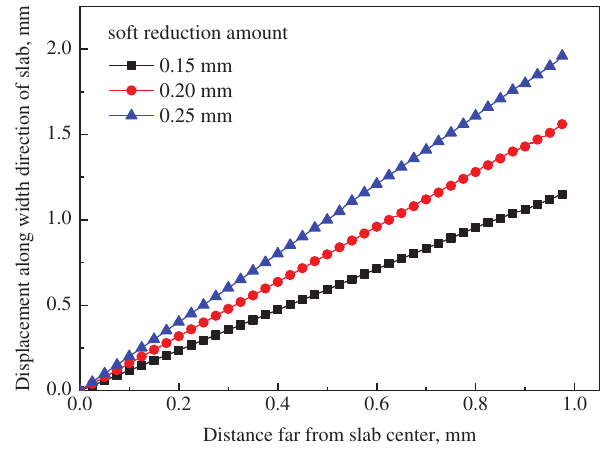
Figure 3: Relationship between displacement along width direction of slab and distance far from slab